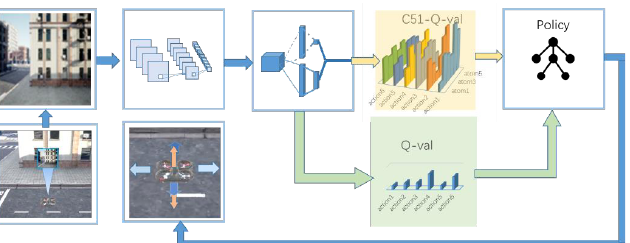
Figure 1. Algorithm schematic, where Q-Val is the original Dueling DQN algorithm, and yellow data stream is the C51-Duel algorithm.